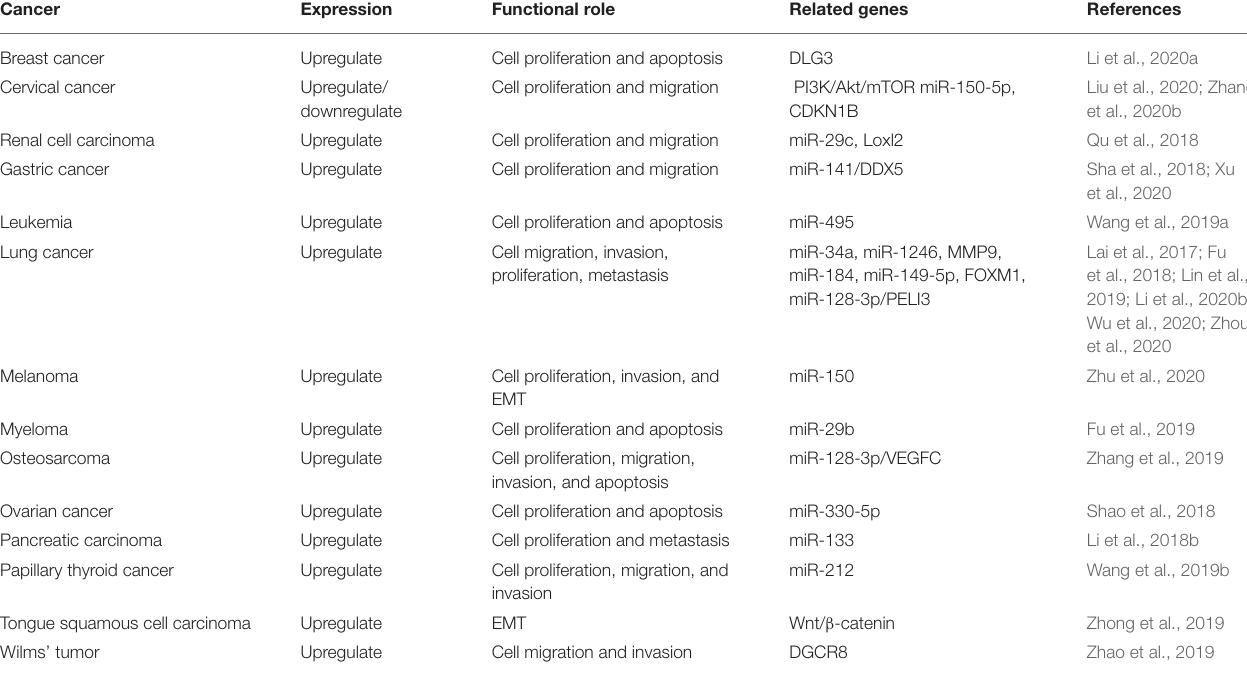
TABLE 4 | Summary of lncRNA MIAT functional roles and related